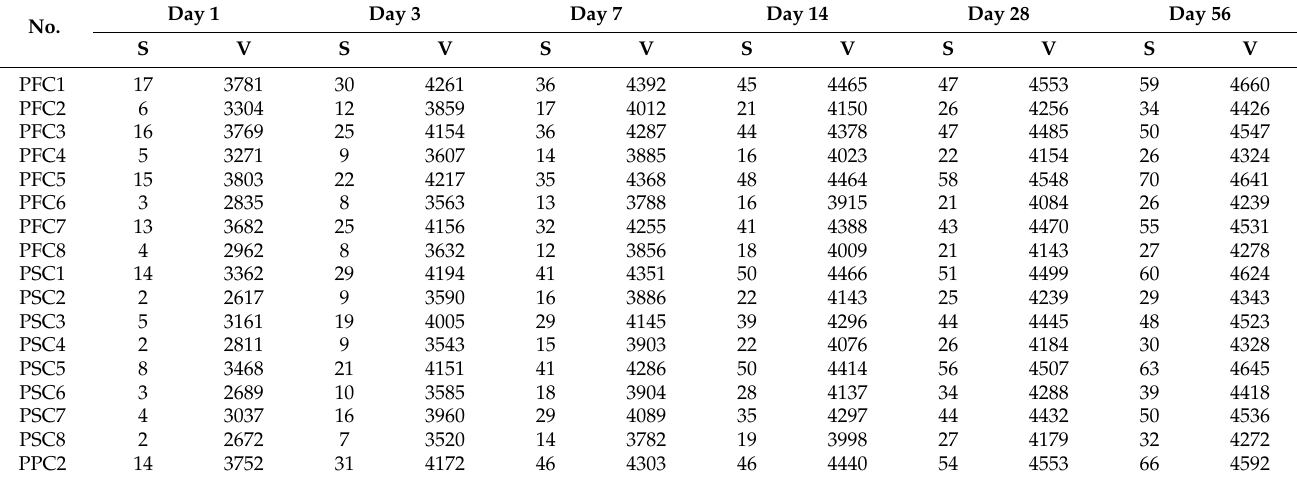
Table 10. The measured UPV and strength data collected for pozzolanic